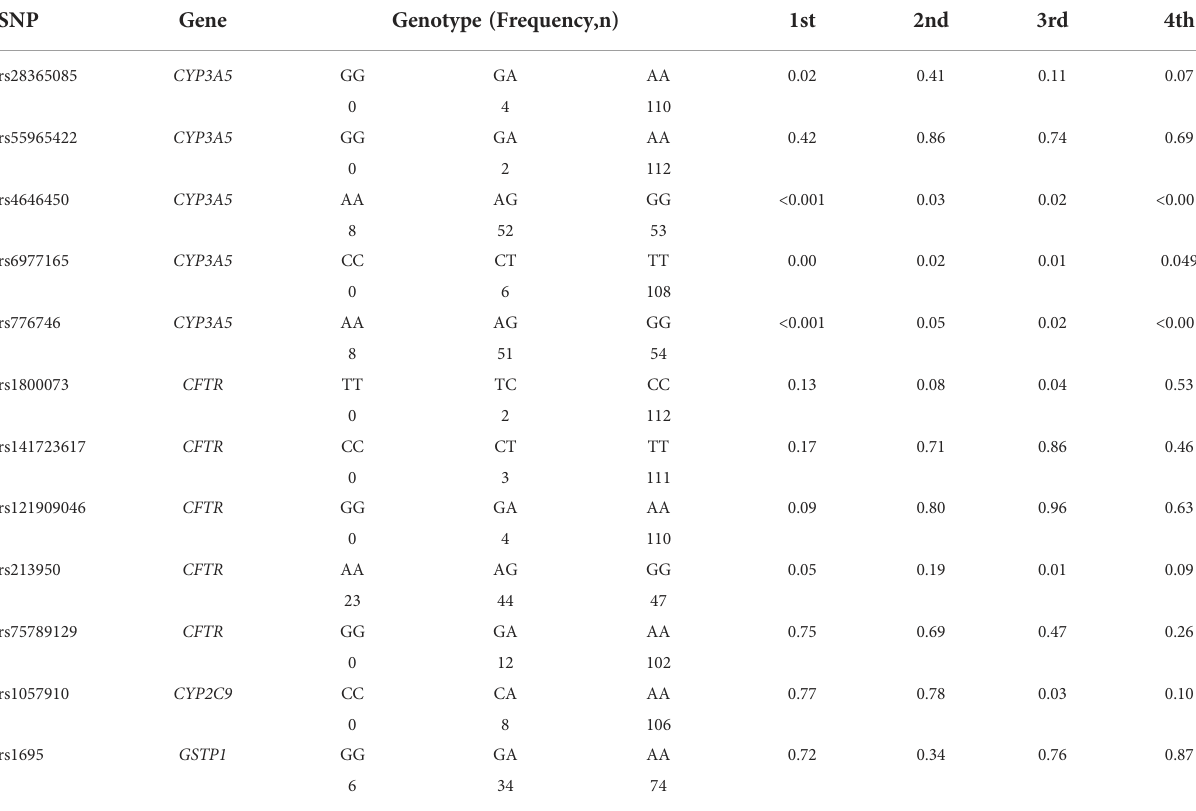
TABLE 4 The association between SNPs of VIPDEGs and tacrolimus pharmacokinetics at the fi rst month after LT. p-value of each